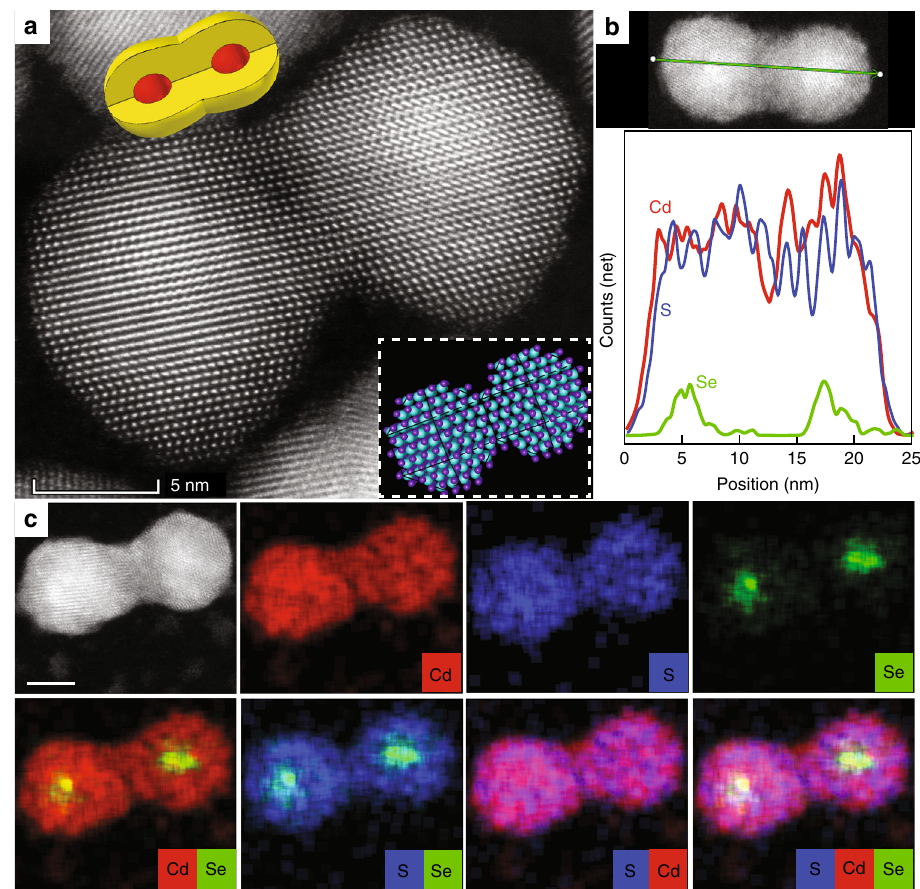
Fig. 2 Dimer structure characterization and analysis. HAADF-STEM image ( a ), EDS line scan data ( b ), and STEM-EDS ( c ) analysis of the coupled 1.9/4.0 nm CdSe/CdS molecules. Inset presents an atomic model. Scale bars 5